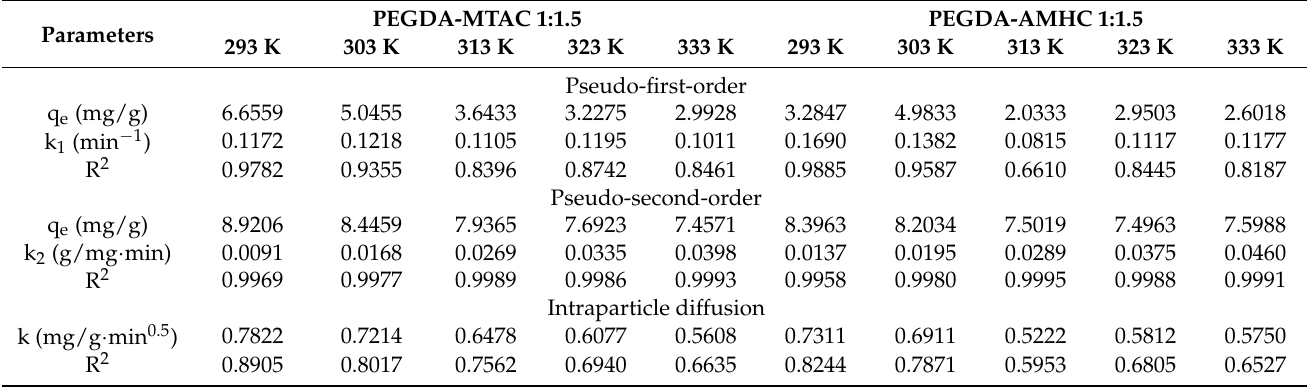
Table 3. Adsorption kinetic parameters of the adsorption of nitrite onto M 1.5 and N 1.5 in aque- ous